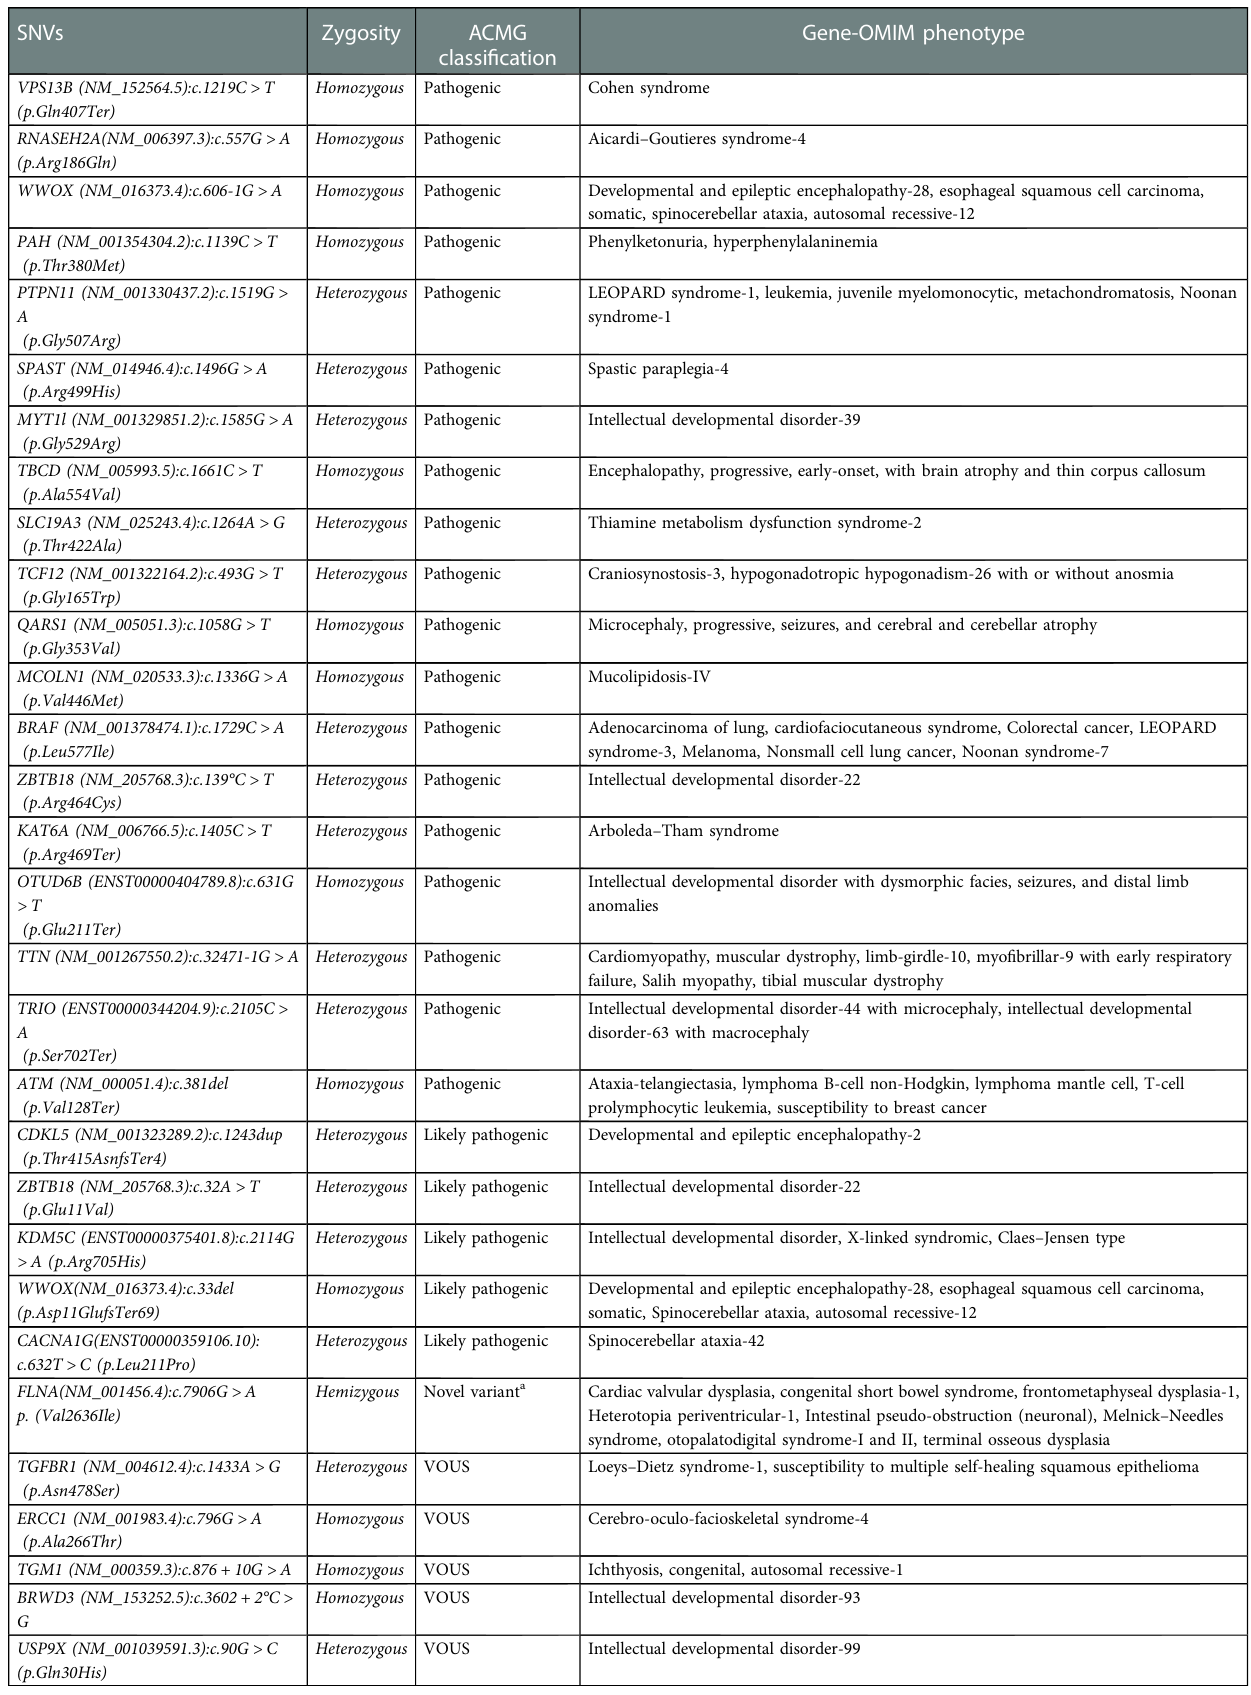
TABLE 2 SNV variants found in